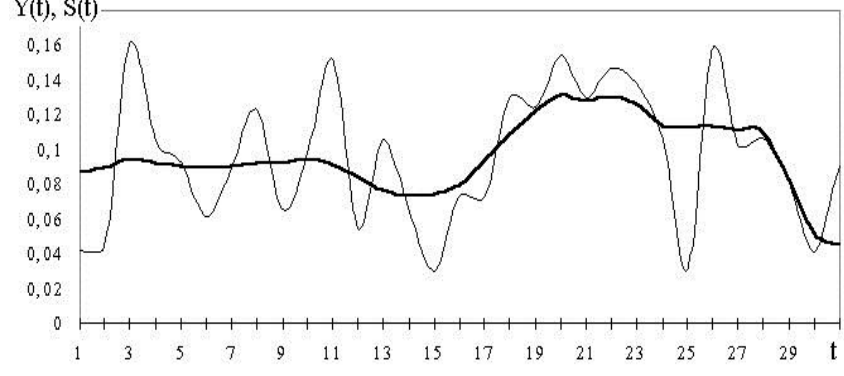
Fig. 6. Fragment of the results of processing by the method of multiplying